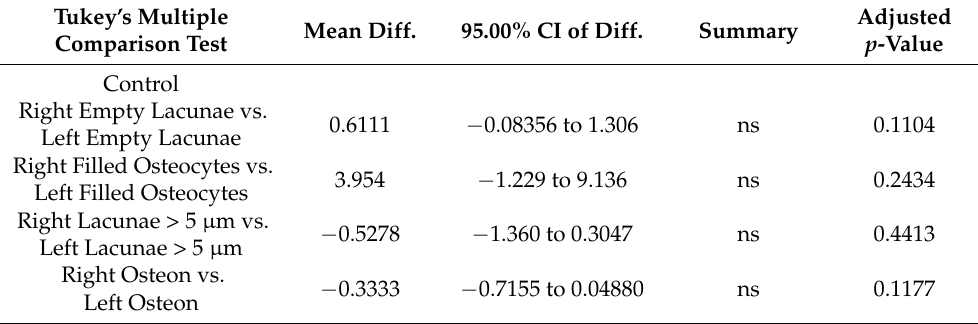
Figure 8. Left and right control implant inter-group comparison graph. Table 6. Left and right control implant inter-group comparison table.